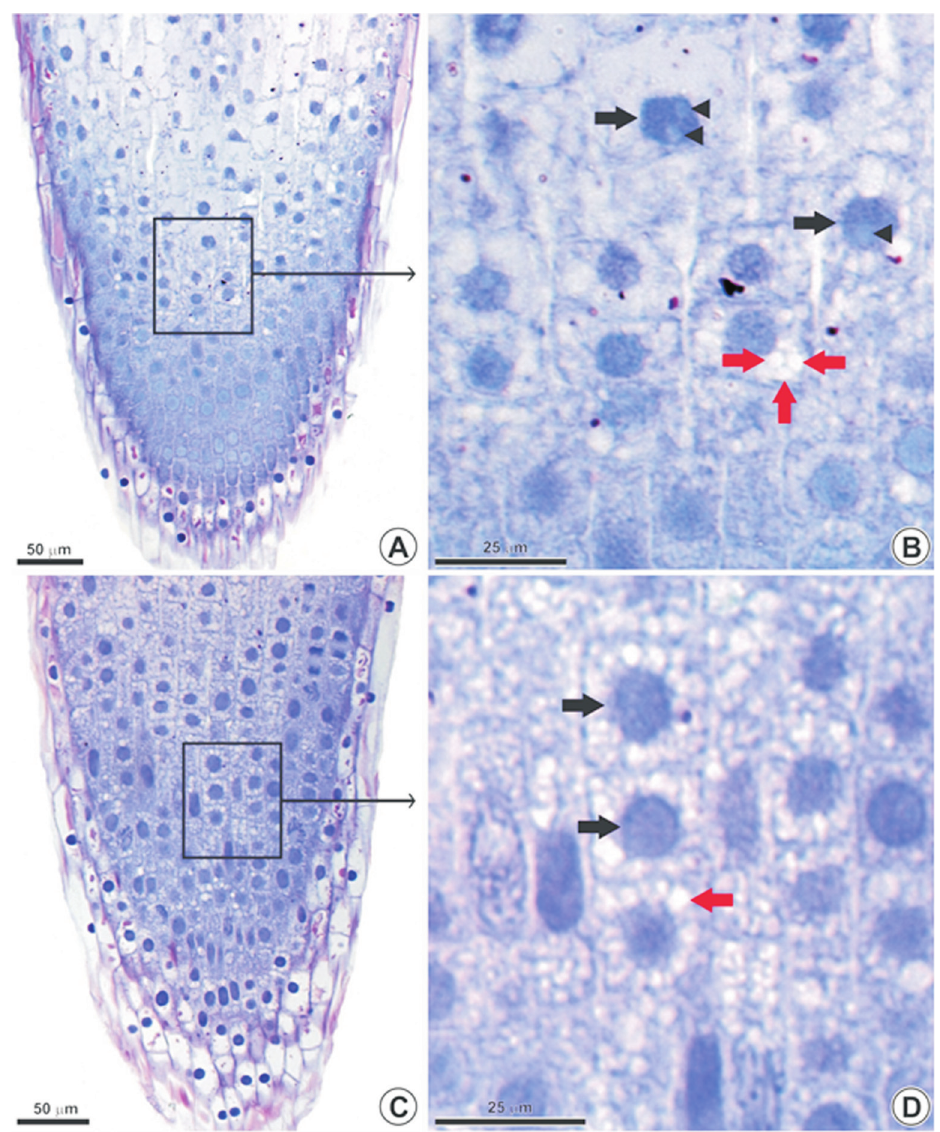
Figure 3 - Root tip of Allium cepa (longitudinal sections) observed in light microscope. Negative control (A-B) and group exposed to 1000 mg/L TiO 2 NP (C-D). (A) Control root tip. (B) Selected region of the apical root meristem in A/B. (C) 1000 mg/L TiO 2 NP. (D) Selected region of the apical root meristem in C/D. Black arrow: nuclei; black arrowhead: nucleoli in evidence; red arrow: vacuoles increased in volume and